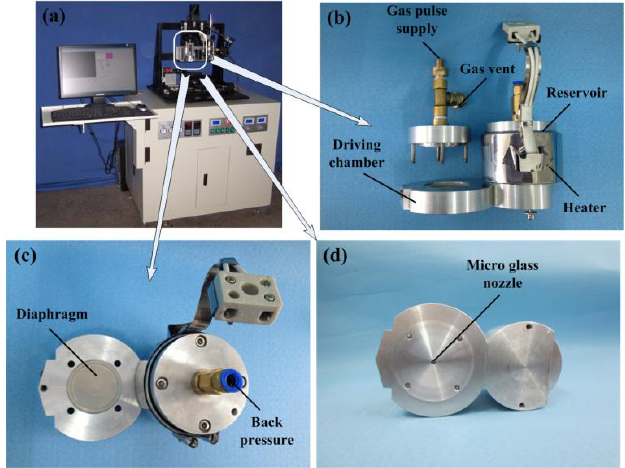
Figure 1. ( a ) Drop-on-demand microjetting system, ( b ) side view, ( c ) top view, and ( d ) bottom view of pneumatic diaphragm microdroplet actuator.